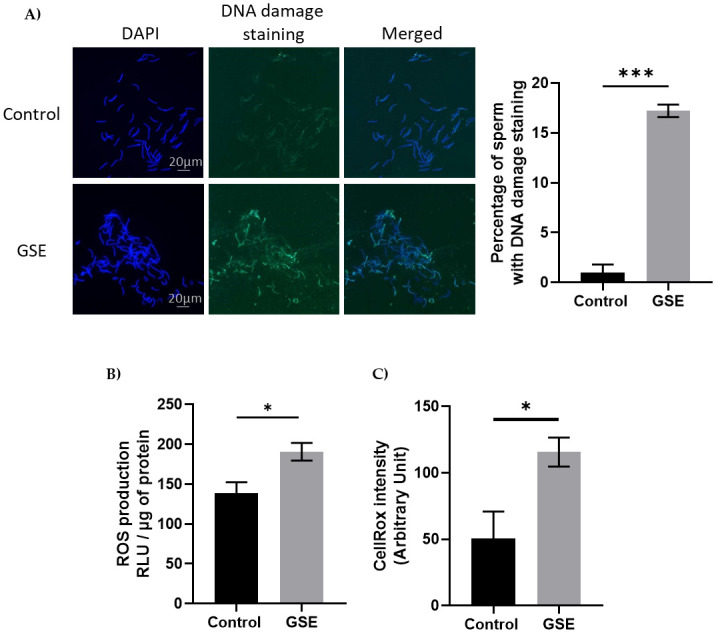
Marker of sperm quality.(A) Representative picture of DNA damage staining on spermatozoa from control or F1-GSE group (200 spermatozoa/animal with n = 5 animals per group) (B) Level of Reactive Oxygen Species (ROS, H202) in spermatozoa (n = 7 per group) and (C) quantification of oxidative stress staining was analysed by CellROX staining. Intensity was quantified using ImageJ (Arbitrary units) (200 spermatozoa/animal with n = 5 animals per group). Results are presented as means ± SEM. *, p < 0.05. ***, p < 0.001.